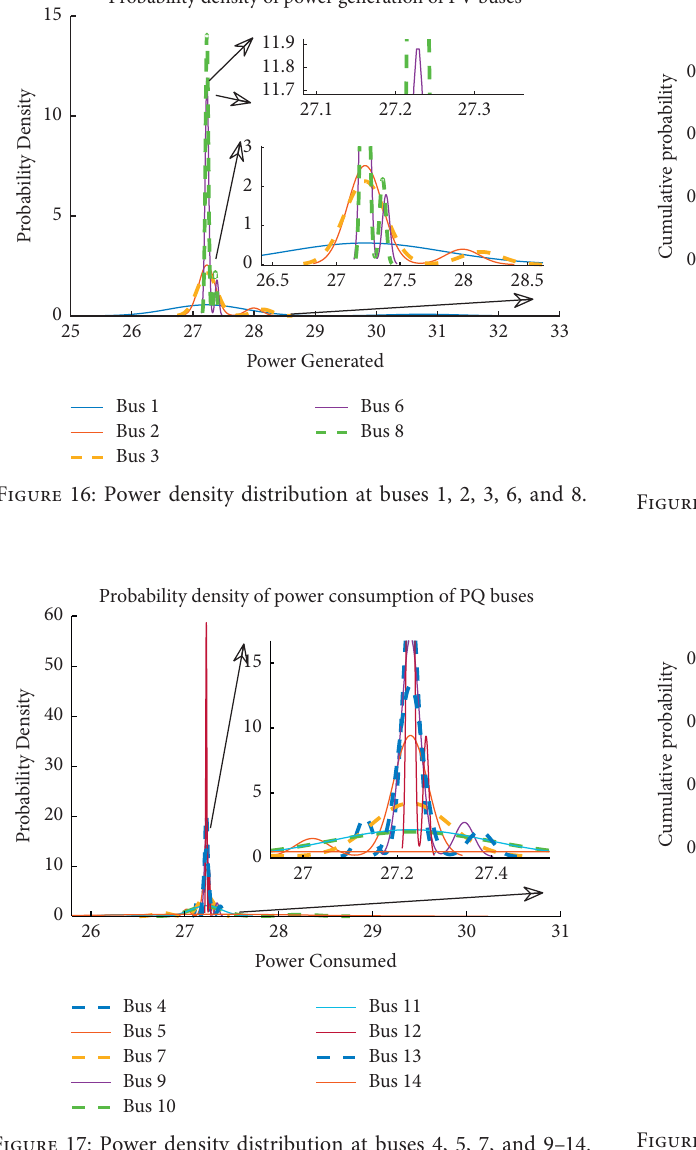
Figure 17: Power density distribution at buses 4, 5, 7, and 9–14.